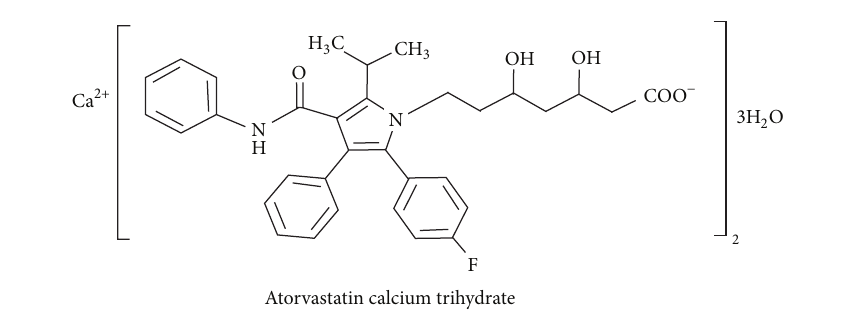
is hydrolyzed by esterases to an inactive carboxylic acid